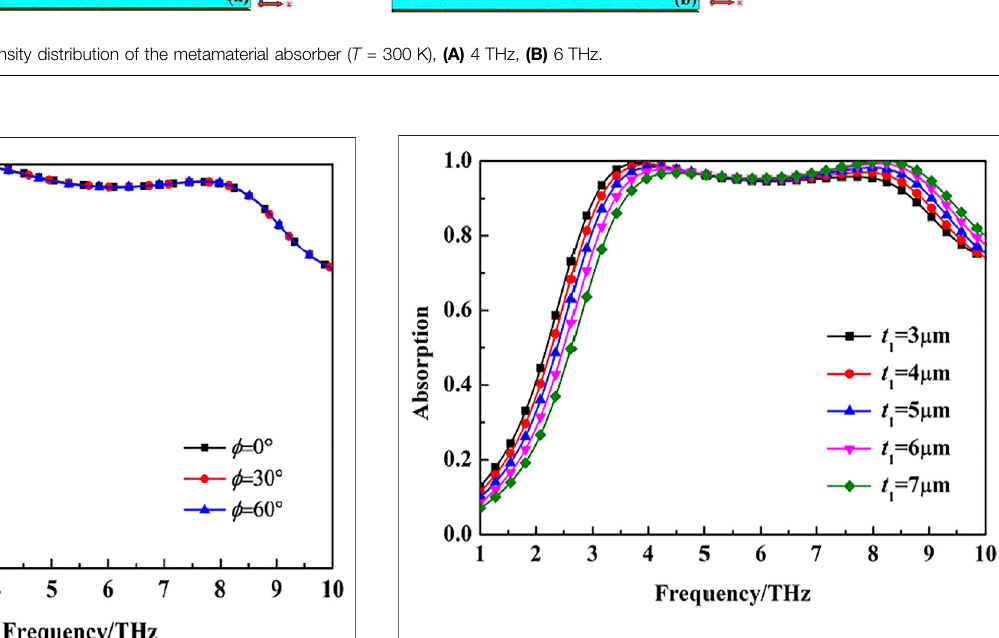
FIGURE 8 | The absorption of the metamaterial absorber with different thickness of VO 2 disk ( T (cid:1) 300 K).